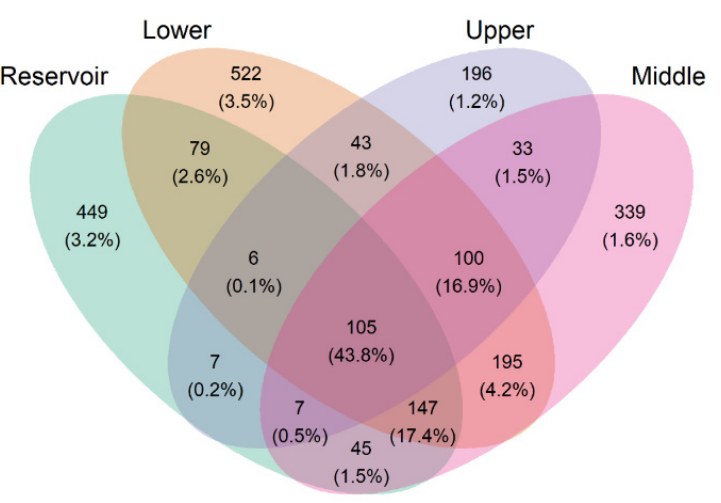
Figure 2. Venn diagram of ASVs and sequences of water sample groups. The numeral data are the ASV numbers and the percentage data are the ratio of the sequence numbers to the total sequence numbers. The Chao1 value (richness) of the water samples drawn from the upper reach was the smallest and significantly lower than at other reaches and the Songtao Reservoir (Figure 3A). The Shannon value (diversity) of the water samples drawn from the upper reach was the smallest and significantly lower than that sampled from the lower reach, but has no significant differences with samples drawn from the middle reach and the Songtao Reservoir (Figure